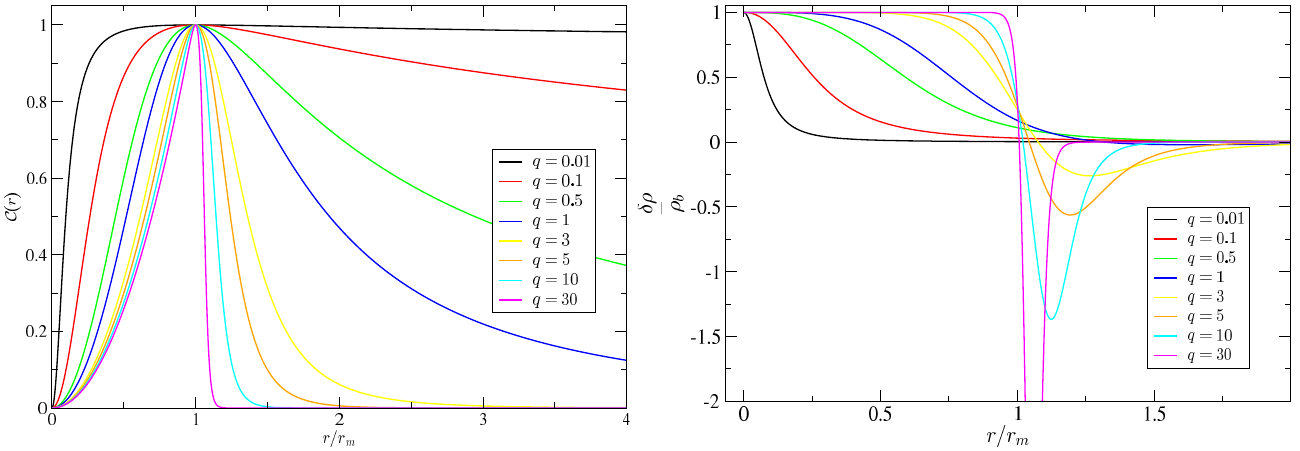
Figure 5. ( Left-panel ): Profiles of C ( r ) of Equation (82) for several values of q . The values δ m are normalised to δ m = 1. ( Right-panel ): Density contrast δρ / ρ b for the same profiles as the top panel. The profiles are normalised to the peak δρ ( r = 0 ) / ρ b . The negative peak value for q = 30 around r = r m goes up to ∼−